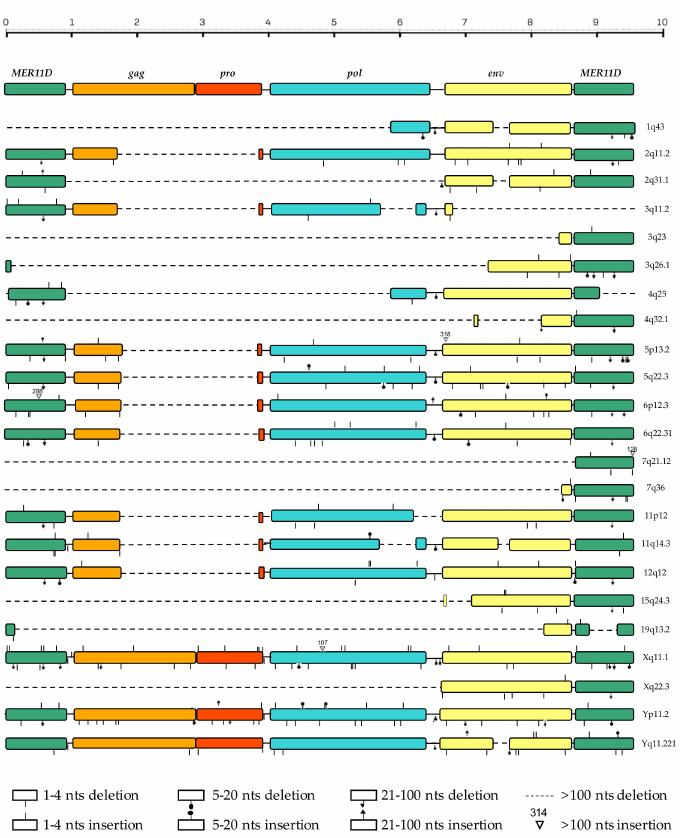
Figure 2. Structural characterization of HML7 proviral loci. The identified HML7 proviruses have been aligned with the Dfam proviral reference, and all insertions and deletions ≥ 1 nucleotide have been